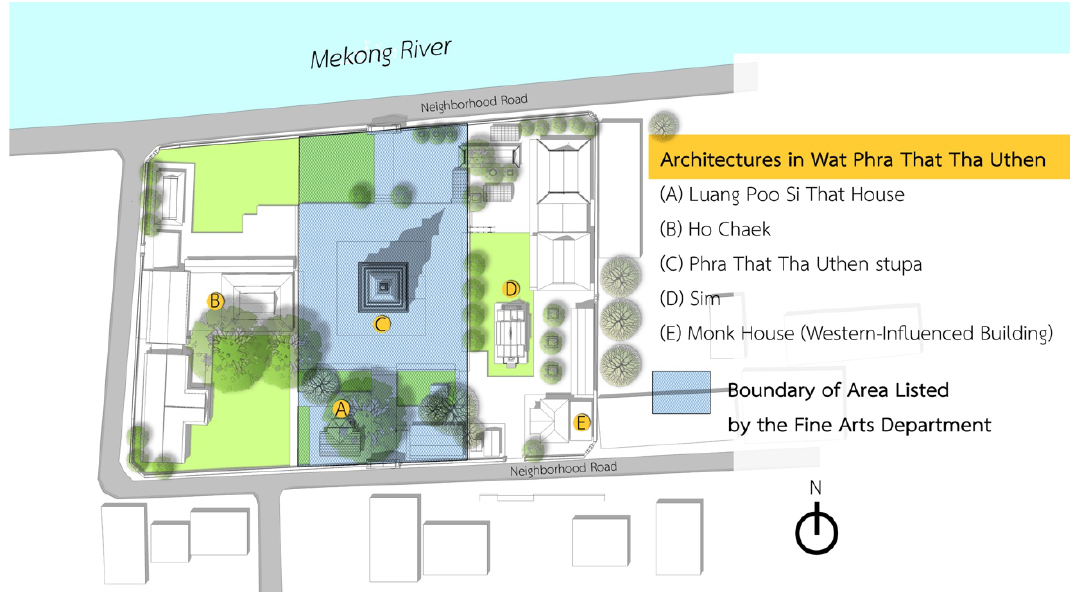
Figure 2. Boundary of Areas Listed by the Fine Arts Department and Location of Important Buildings in the Area of Wat Phra That Tha